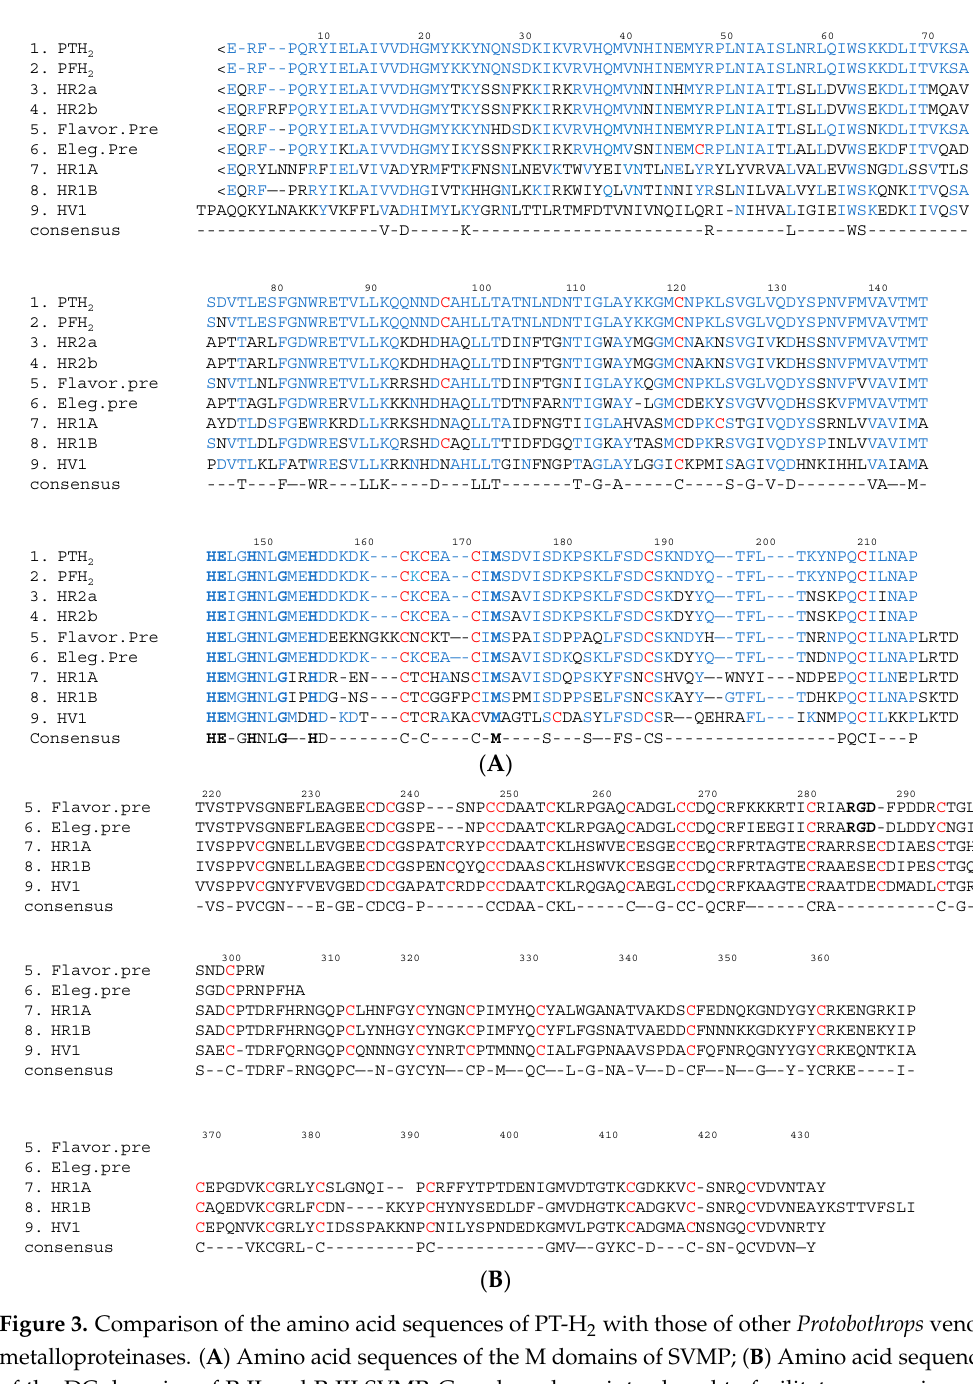
Figure 3. Comparison of the amino acid sequences of PT-H 2 with those of other Protobothrops venom metalloproteinases. ( A ) Amino acid sequences of the M domains of SVMP; ( B ) Amino acid sequences of the DC domains of P-II and P-III SVMP. Gaps have been introduced to facilitate comparisons of sequence similarity. <E is pyroglutamic acid. The cysteine residues are shown in red. The binding site for Zn 2+ and the Met-turn amino acid residues are shown in bold. The amino acid sequence of PT-H 2 and the conserved amino acid residues are shown in blue. M domain: position 1–214; D domain: